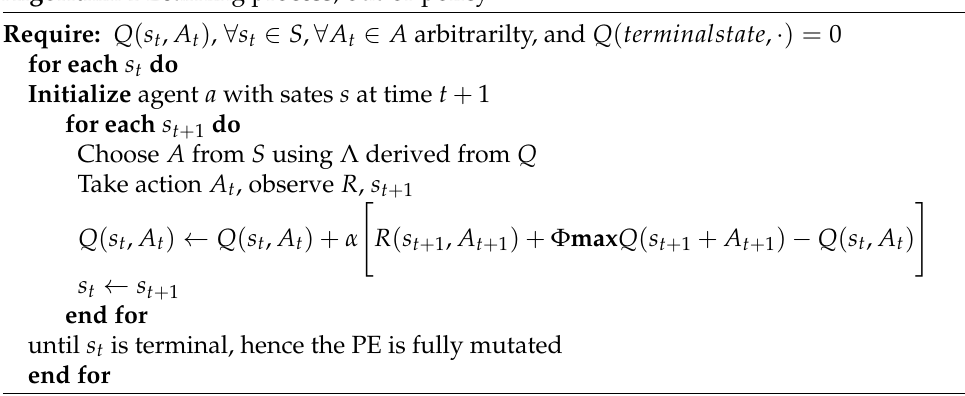
Algorithm 1 Learning process, out-of-policy